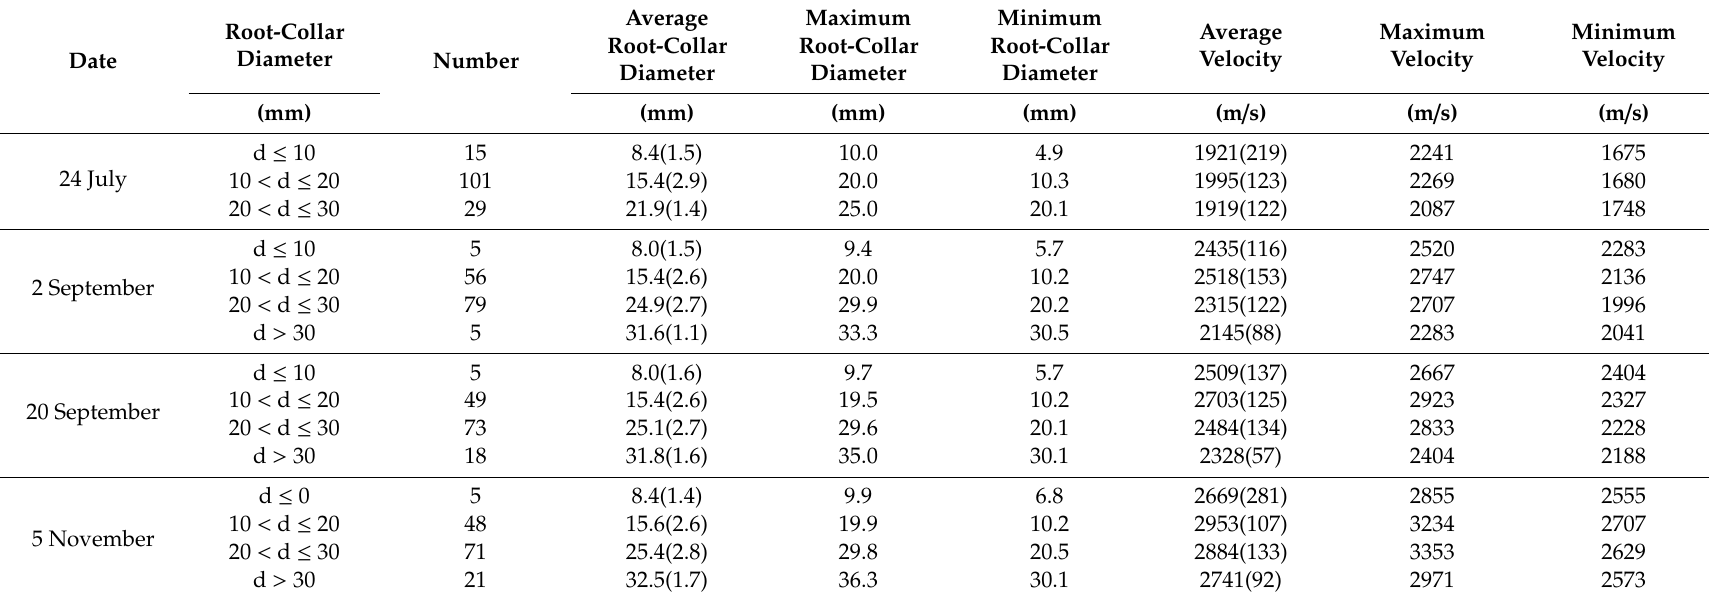
Table 1. Results of ultrasonic velocity and root-collar diameter for 145 poplar